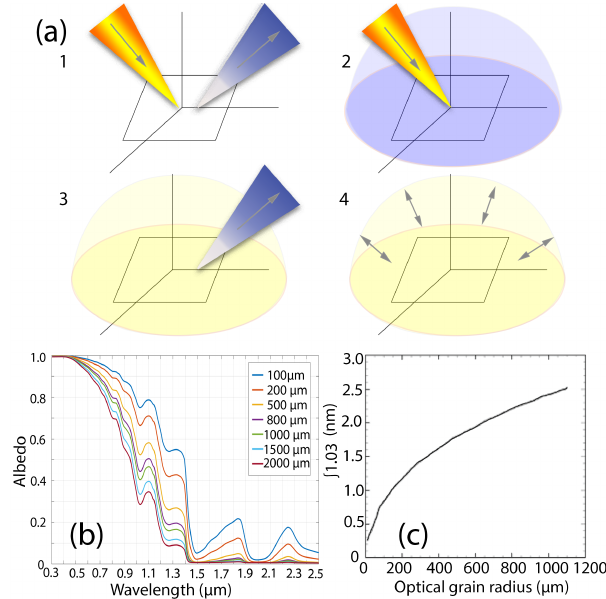
Figure 1. (a) Diagram of the four measurable reflectance scenarios described by Nicodemus et al. (1977). 1 is biconical reflectance, 2 is conical hemispheric reflectance (blue hemisphere represents outgoing radiance), 3 is hemispheric-conical reflectance (yellow hemisphere represents incoming radiance), 4 is bihemispheric re- flectance. (b) Spectral albedo for clean snow with grain radii 100– 2000µm, solar zenith is 60 ◦ , no impurities; (c) relationship between optical grain radius and the integral of the 1.03µm absorption fea- ture, redrawn from Painter et al.